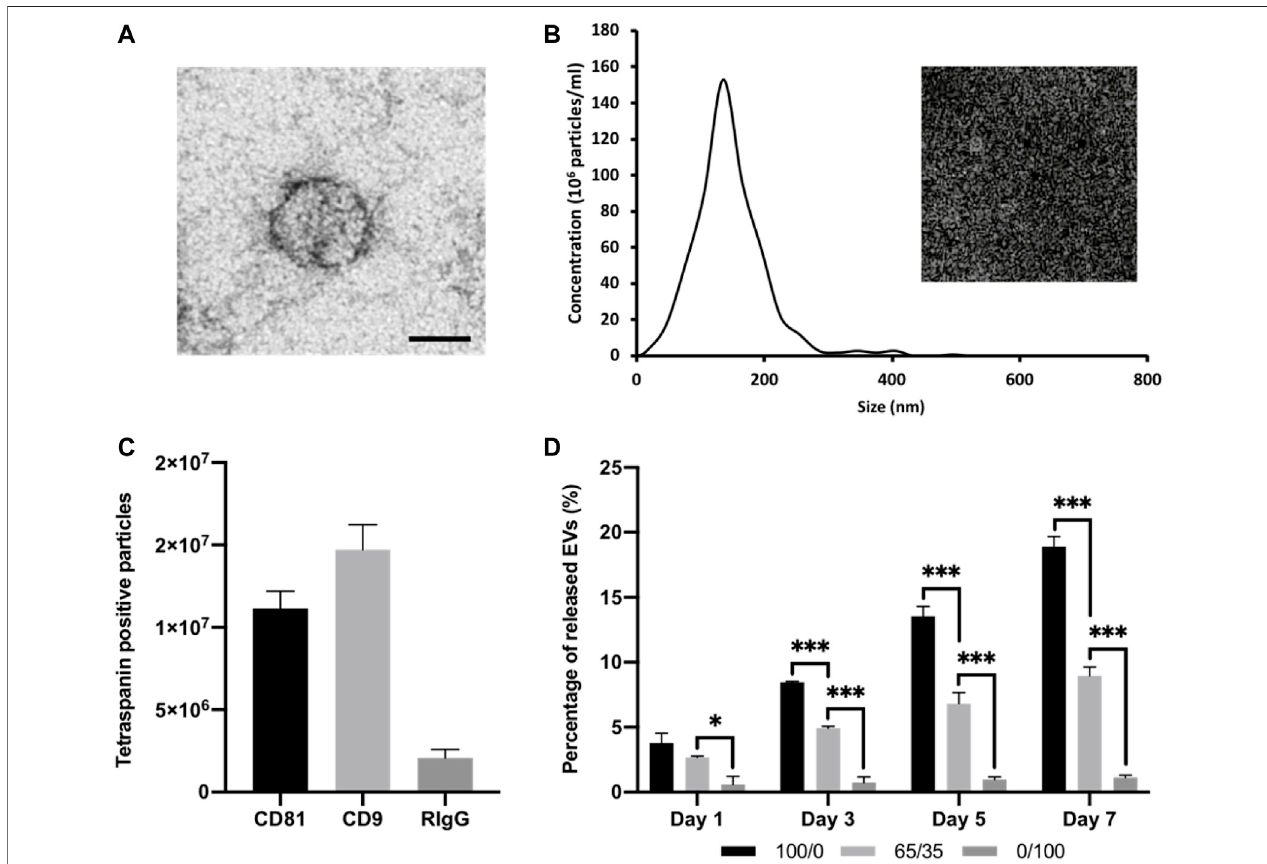
FIGURE4| Characterisationofisolatedosteoblast-derivedEVsandhydrogel-EVreleasekinetics. (A) TEMimageofEVs.Scalebar=50 nm. (B) Sizedistributionof isolated EV by NTA. Insert shows snapshot of particles during analysis. (C) Detection of tetraspanin-positive nanoparticles (CD81 and/or CD9) via interferometry after immuno-capture onto ExoView ™ chip. (D) Quanti fi cation of EVs released from chitosan-collagen hydrogels assessed via CD63 positive ELISA. Data are expressed as mean ± SD ( n = 3). * p ≤ 0.05, ** p ≤ 0.01, and *** p ≤ 0.001.